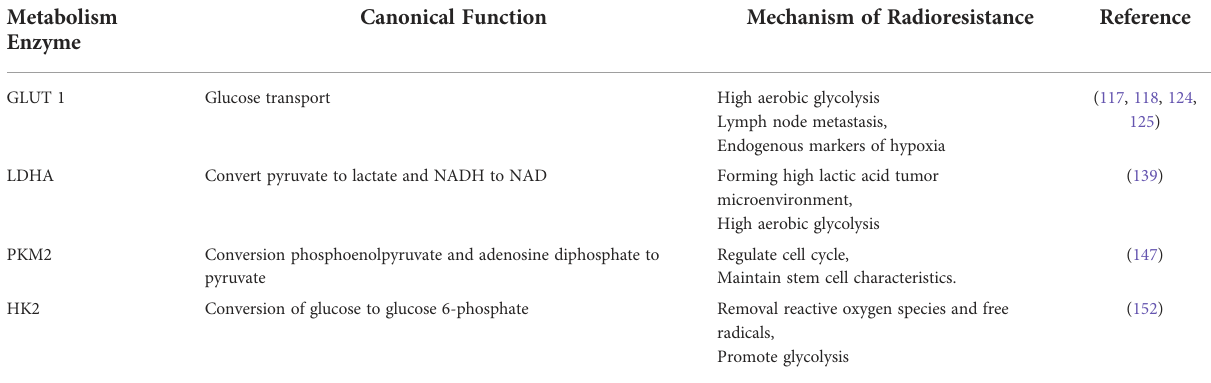
TABLE 3 List of glycolysis related proteins in cervical cancer radioresistance. Metabolism